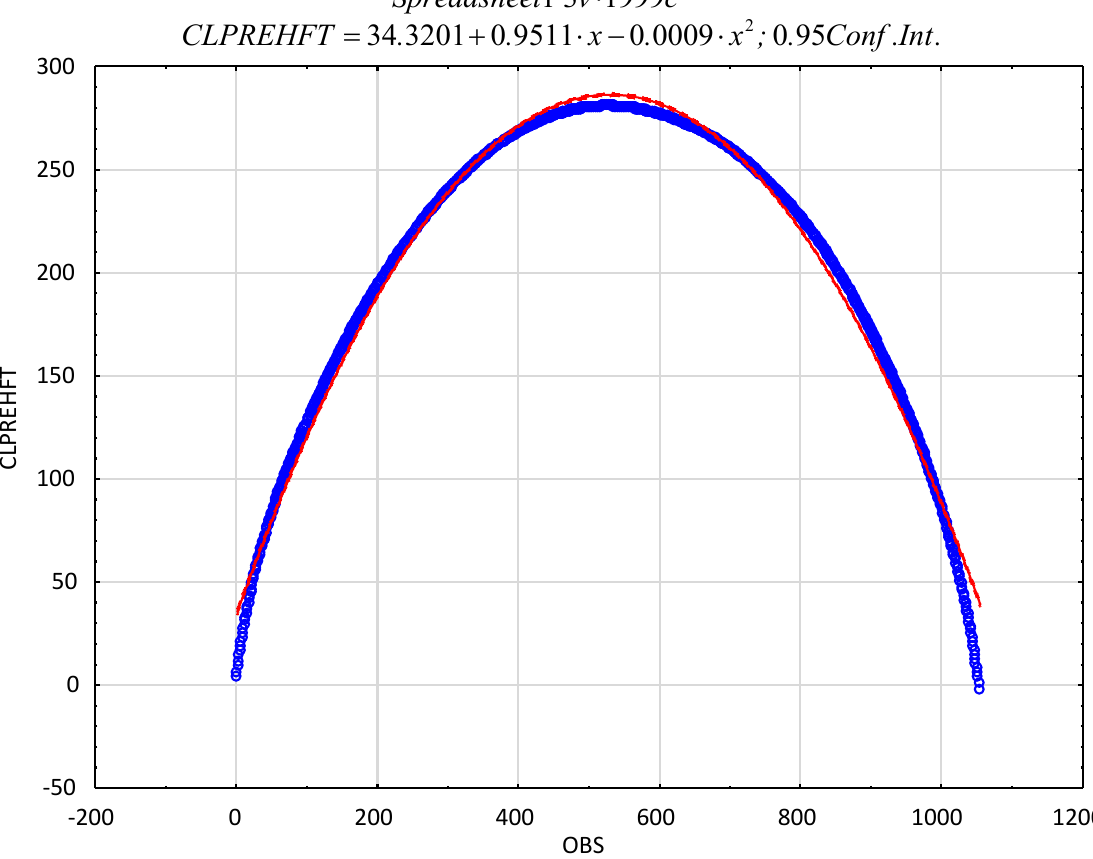
Figure 1. Depicting cumulative Log-periodic Re HFT as a function of its